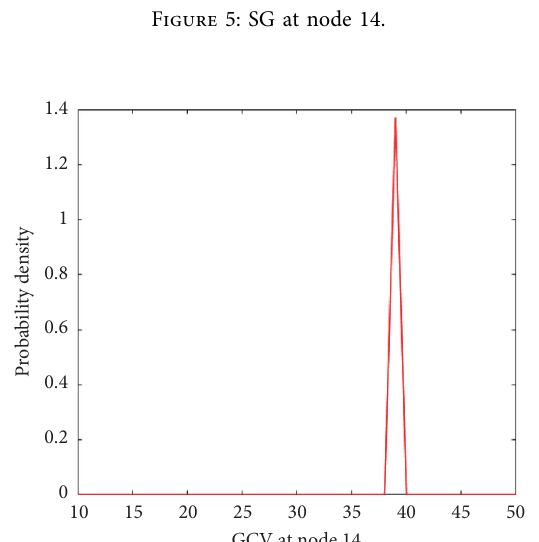
Figure 5: SG at node 14.